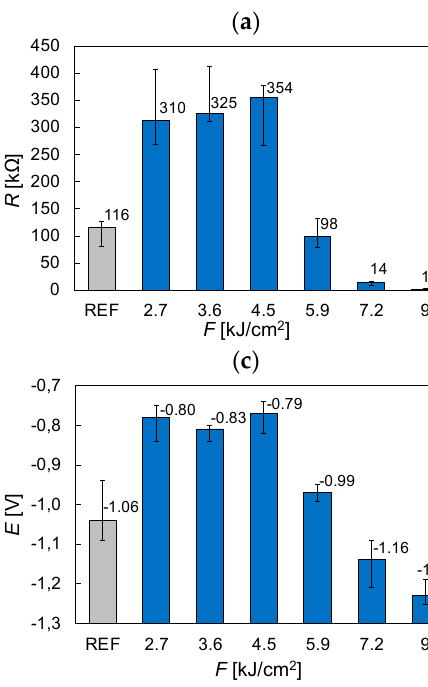
Figure 4. Electrochemical measurements: ( a ) the polarization resistance R , ( b ) corrosion current density J , and ( c ) potential E as a function of laser energy density ( V = 10 mm / s, h = 10 µ m, PRR = 80 kHz), taken in a 3.5% NaCl environment. The results are the average of five measurements.